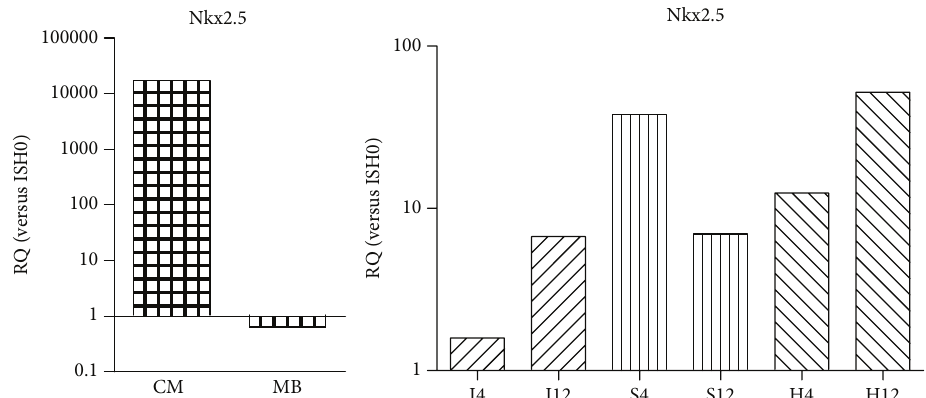
Figure 4: Expression of cardiomyocyte-specific transcripts in MDSCs cultured under dynamic support. Skeletal myoblasts, purified embryonic stem cell-derived cardiomyocytes, and cells from I, S, and H cell culture conditions on days 4 and 12 of cultivation were analyzed by qPCR. Expression levels of indicated genes were normalized to the reference gene 𝛽 -actin and displayed as relative expression compared to ISH0 cells. Calculation of statistical significance was based on Δ Ct values (see Figure S8). ∗/∗∗/∗∗∗ 𝑝 < 0.05/0.01/0.001 .